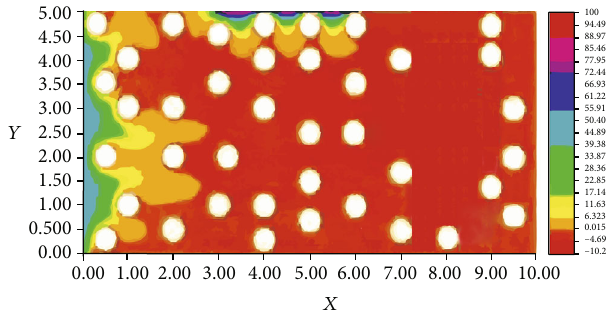
Figure 14: Concentration, D = 0 : 5 , C